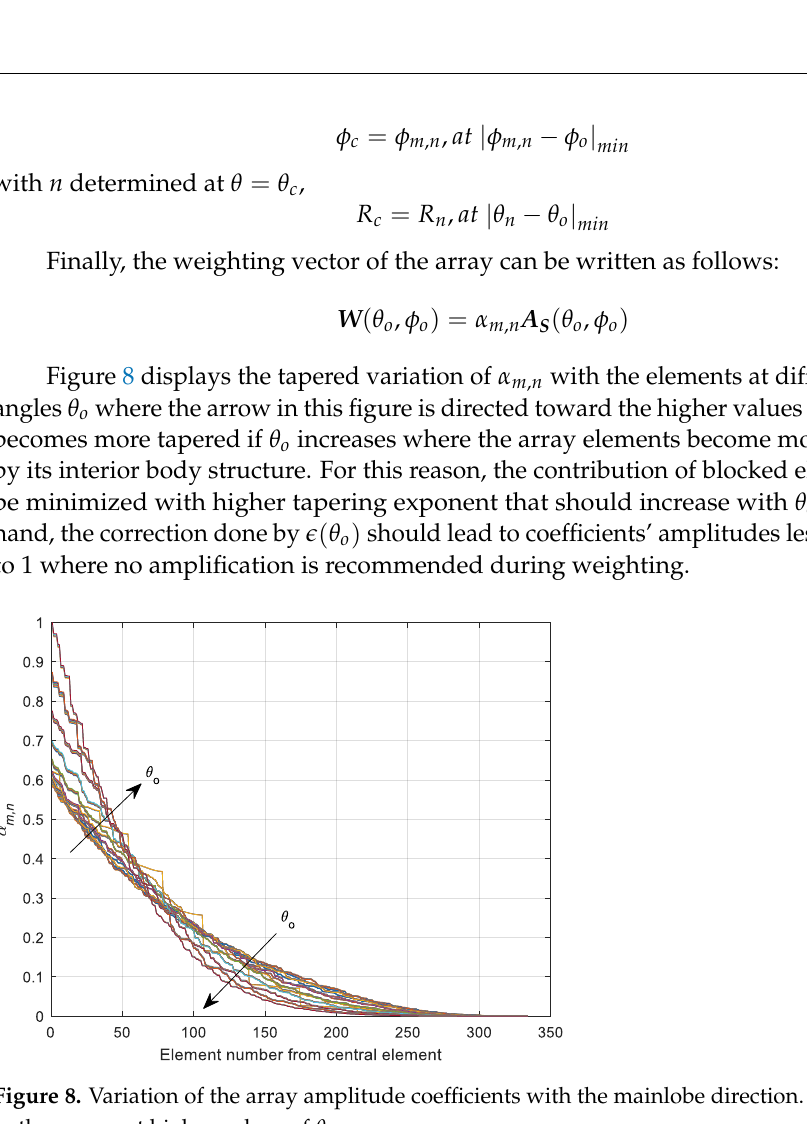
Figure 8. Variation of the array amplitude coefficients with the mainlobe direction. The arrows refer to the curves at higher values of (cid:2016) (cid:3042) .